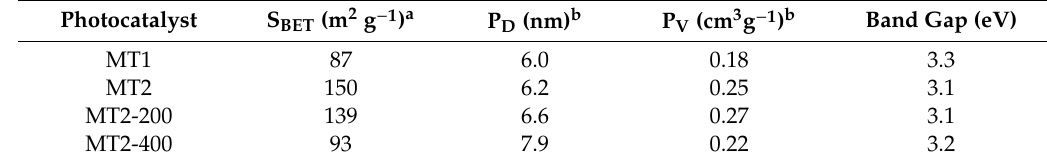
Table 1. Textural properties and band gap of the synthetized samples.